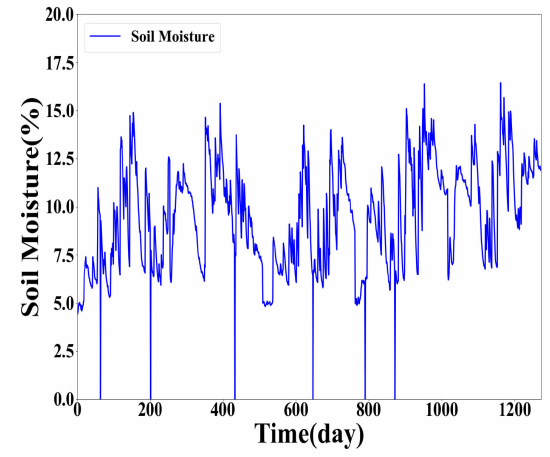
Figure 1. Full data of daily average soil